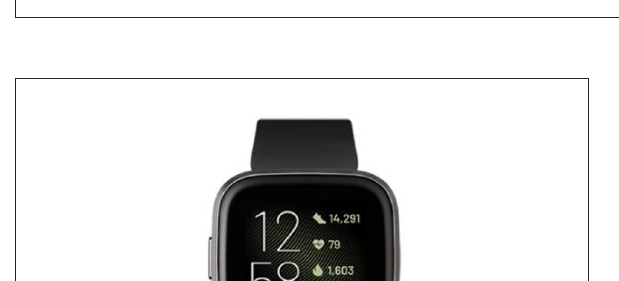
FIGURE2 Flowchart of methodology.